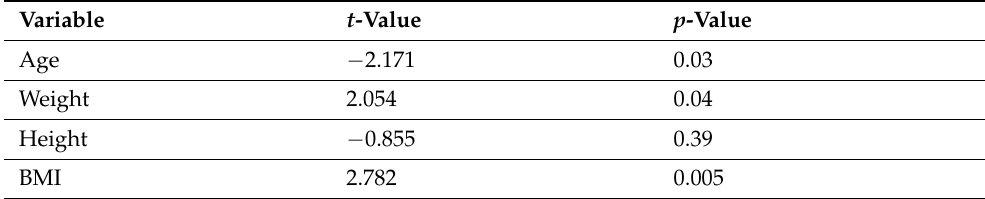
Table 2. t -test for independent variables